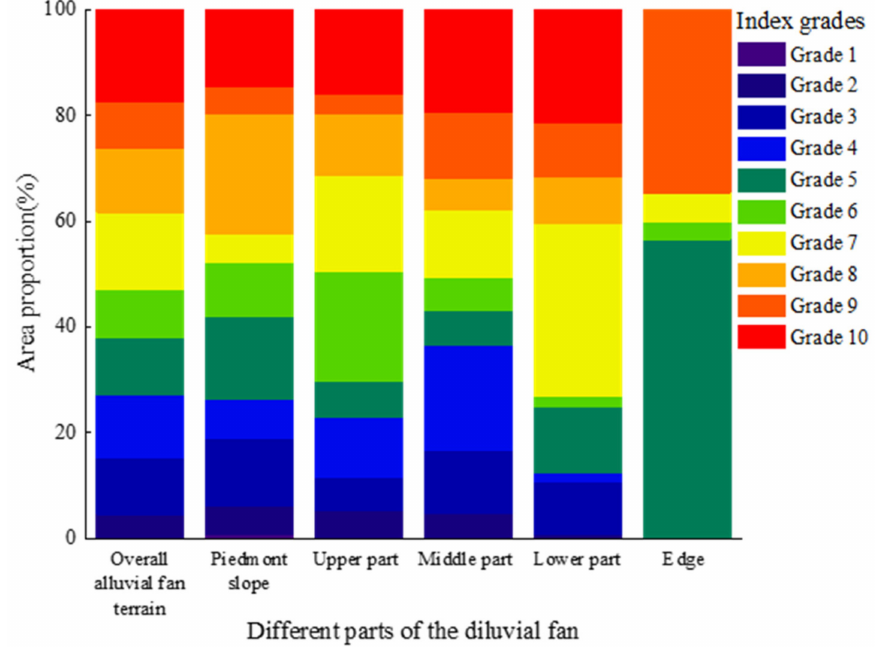
Figure 12. Area proportion of the cultivated land quality at different parts of the diluvial